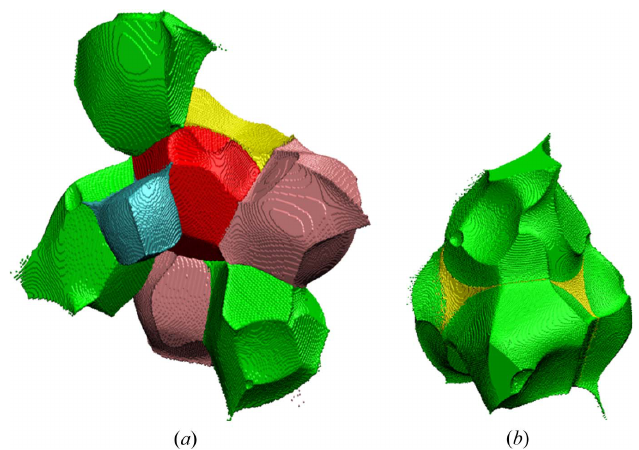
Figure 8 ( a ) Atomic basin of O9 (red shape) surrounded by basins belongs to sulfur (yellow), magnesium (cyan), oxygen (green) and potassium atoms (pink); ( b ) SO 4 group (green – oxygen, yellow – sulfur).